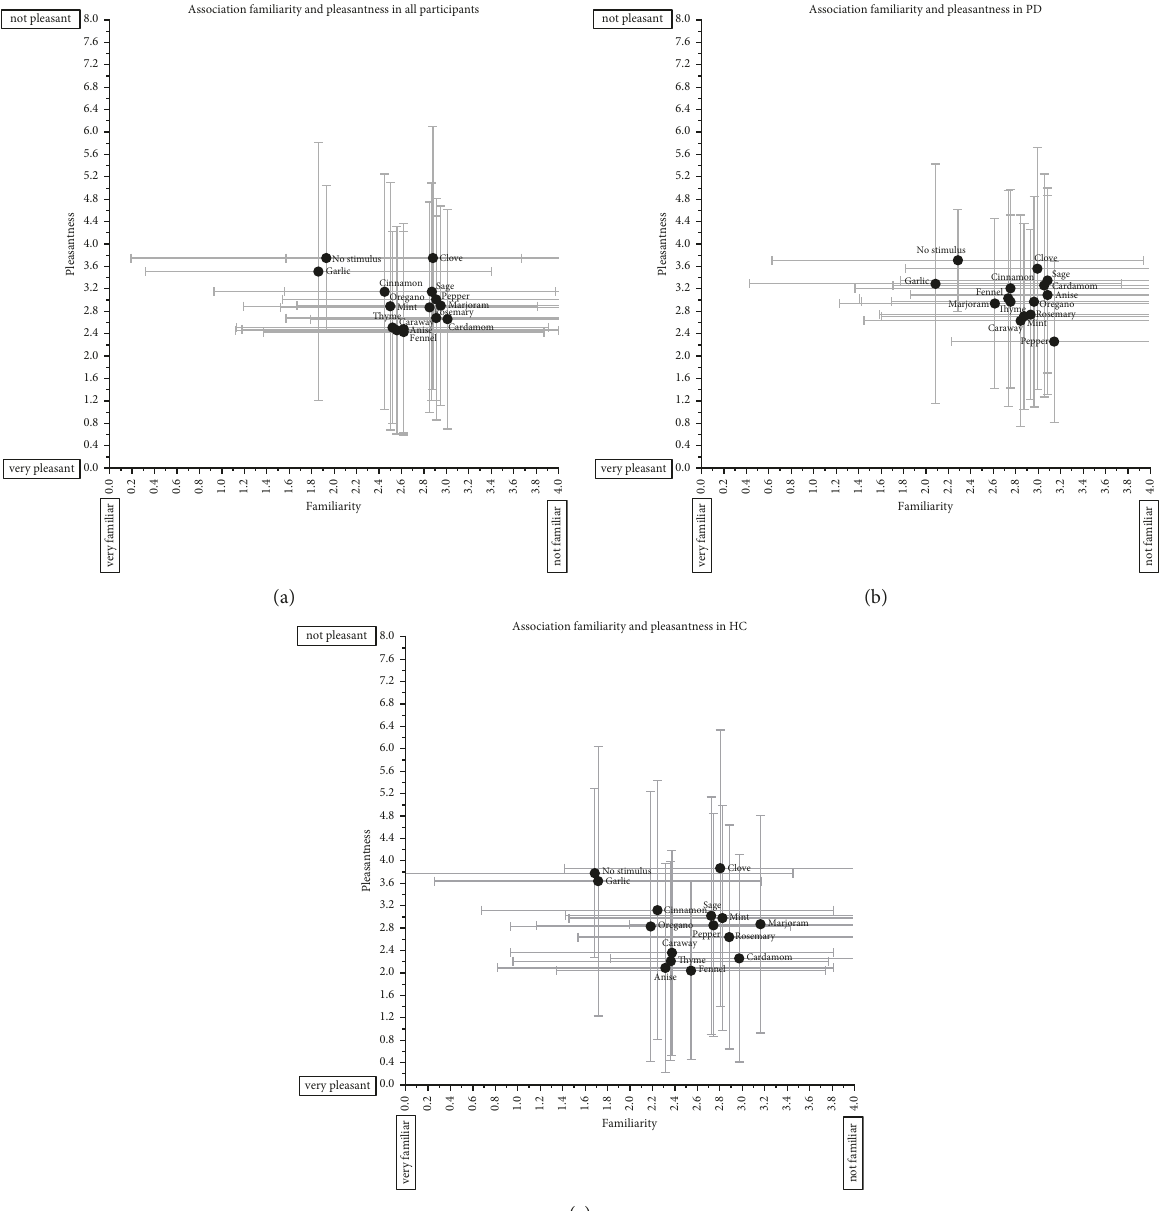
Figure 3: Correlation between mean pleasantness and mean familiarity of the spice odorants, in all participants (a), in Parkinson’s disease patients (b), and healthy controls (c). Data are presented as mean ± SD; PD, Parkinson’s disease, HC, healthy